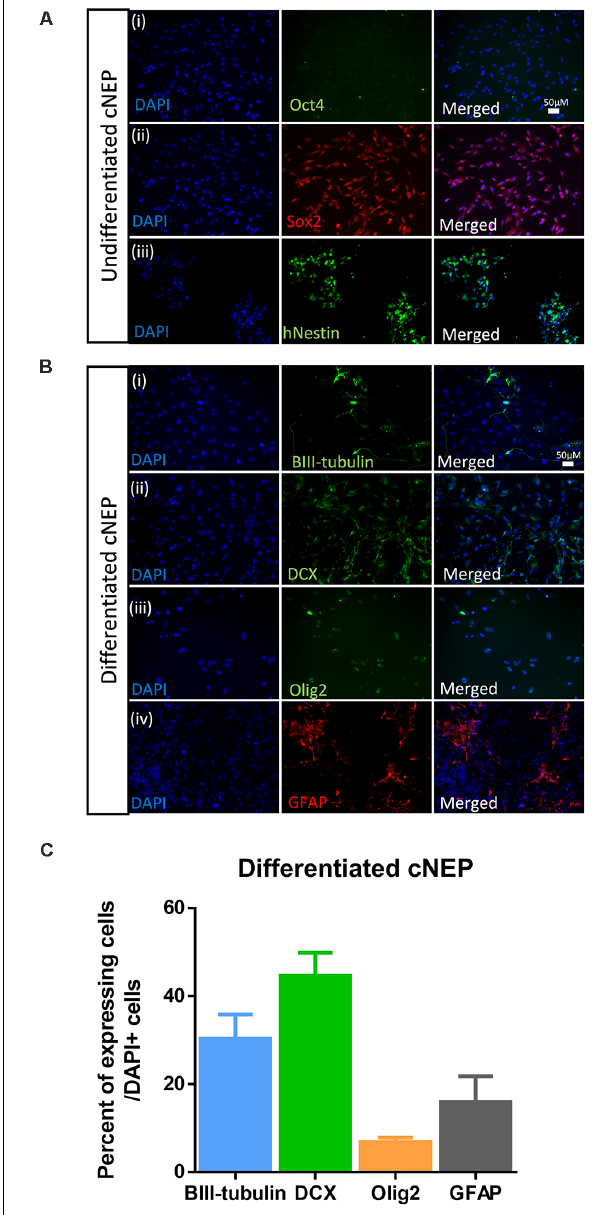
FIGURE 1 | Embryonic stem cell (ESC) derived cortical neuroepithelial cells (cNEPs) are neurally committed, multi-potent cells. (A) ESC were induced into cNEPs and then passaged or differentiated in media prior to immunocytochemistry. ESC derived cNEPs do not express the pluripotency marker OCT4 (i) and do express the undifferentiated neural precursor markers Sox2 (ii) and human Nestin (hNestin) (iii) . (B) cNEPs were plated on day 0 in differentiation media for 14 days. Subpopulations of cells express BIII-tubulin (i) , DCX (ii) , Olig2 (iii) and GFAP (iv) . Scale bars = 50 µ m. (C) Quantification of differentiation markers. n > 3 independent